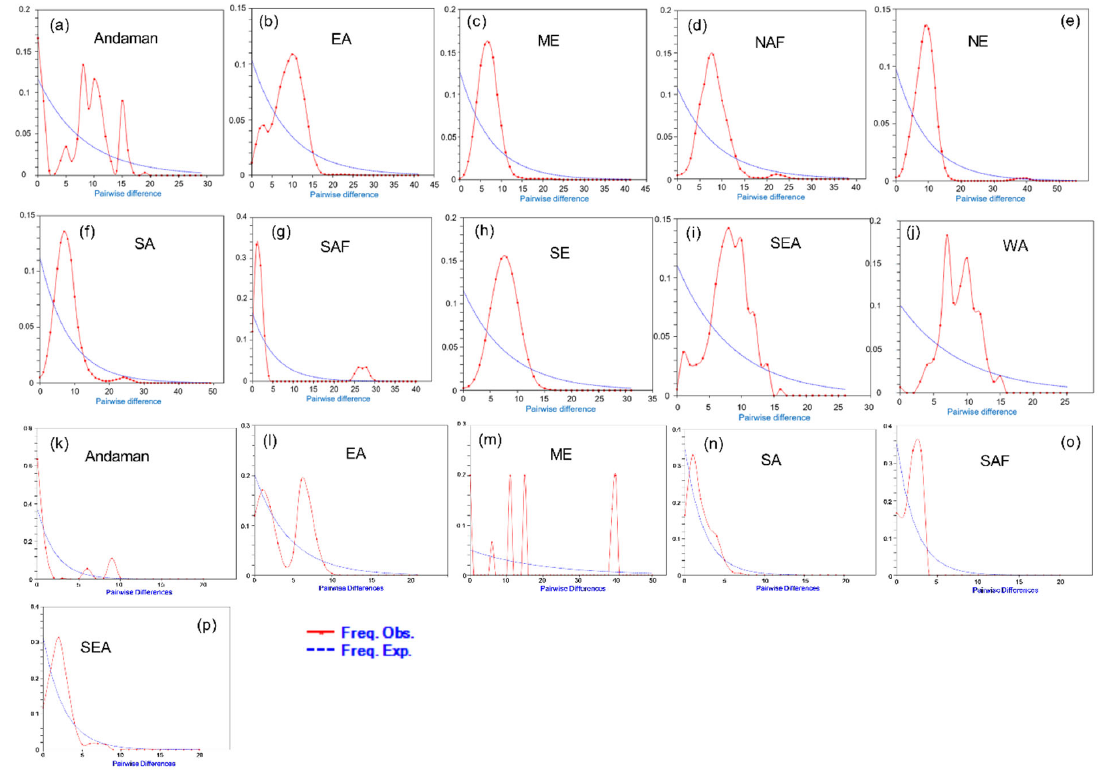
Figure 5. Mismatch distribution graph of Andaman goats and other goats of different regions (( a – j ): Haplogroup A) and (( k – p ): Haplogroup B). The x and y axis present the number of pairwise differences and the relative frequencies of pairwise comparisons, respectively. Mismatch distribution graph was drawn in DnaSP v 6 [30]. Table 4. Neutrality tests of haplogroup A goats of Andaman and other regions .